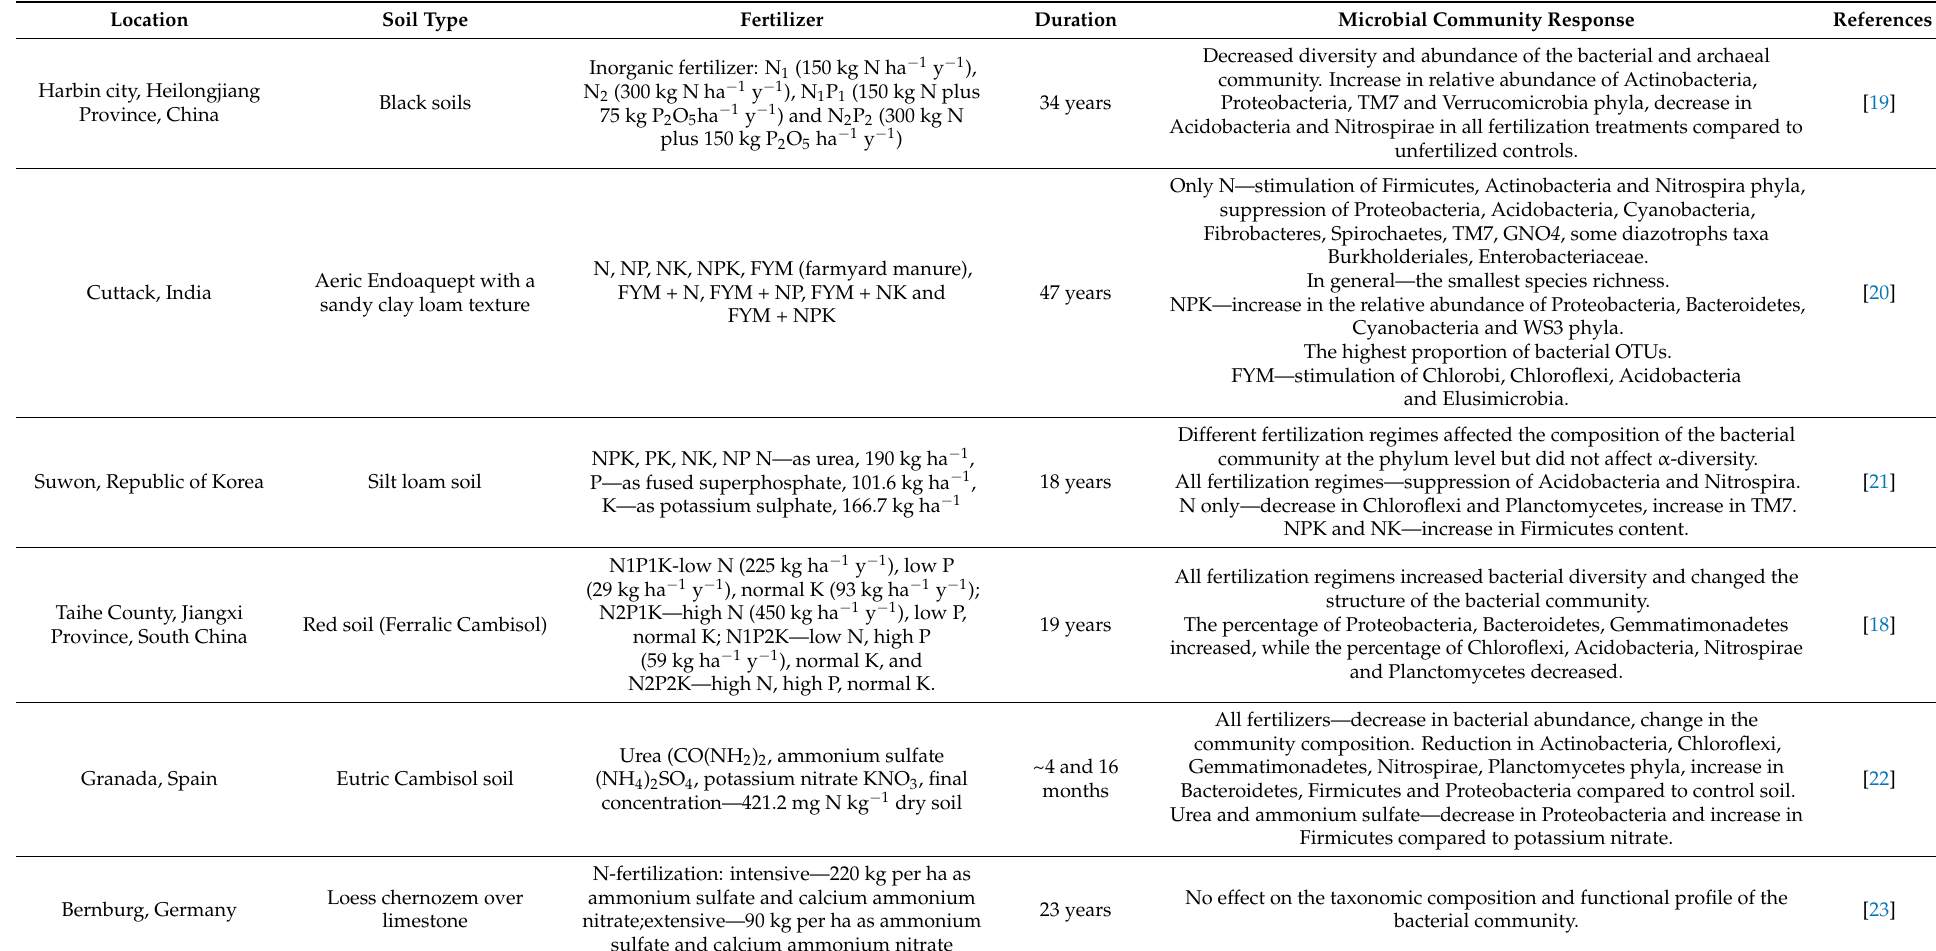
Table 1. Effect of fertilizers on the bacterial community of agricultural